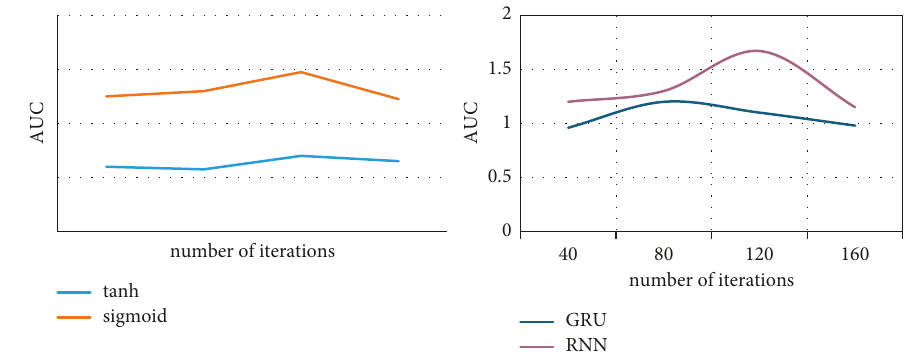
Figure 14: Changes in the AUC value of the model in group